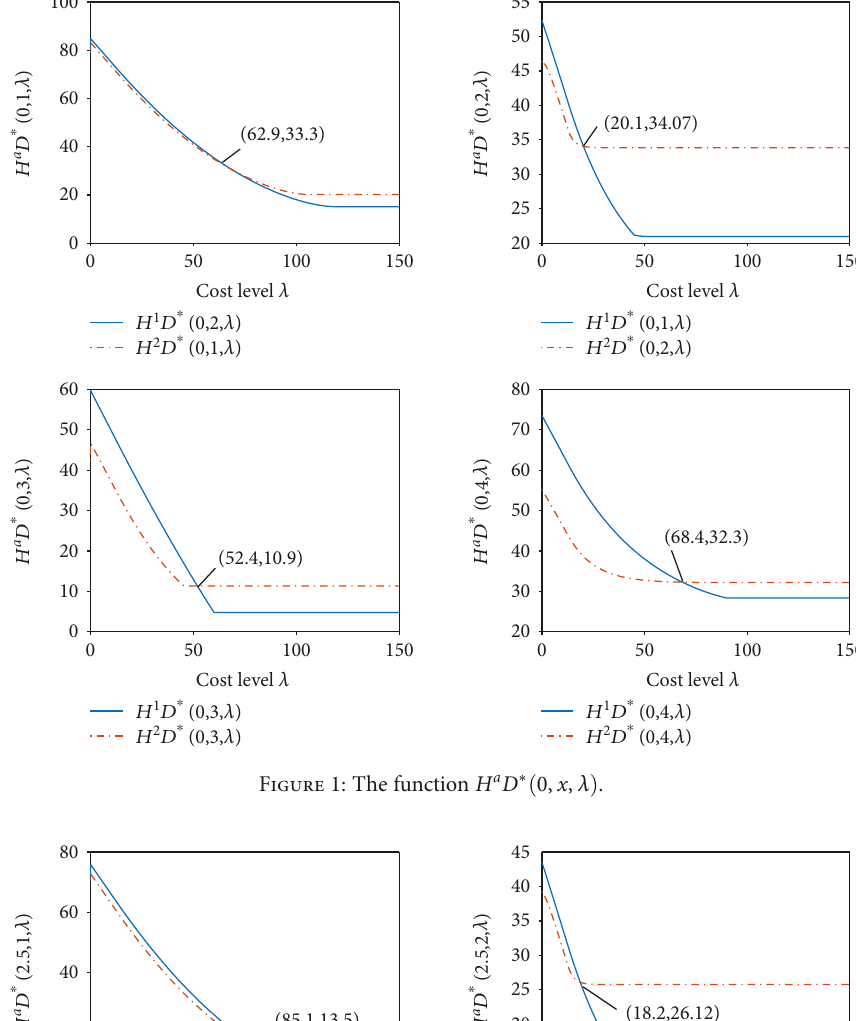
Figure 1: The function H a D ∗ 0, x , λ .